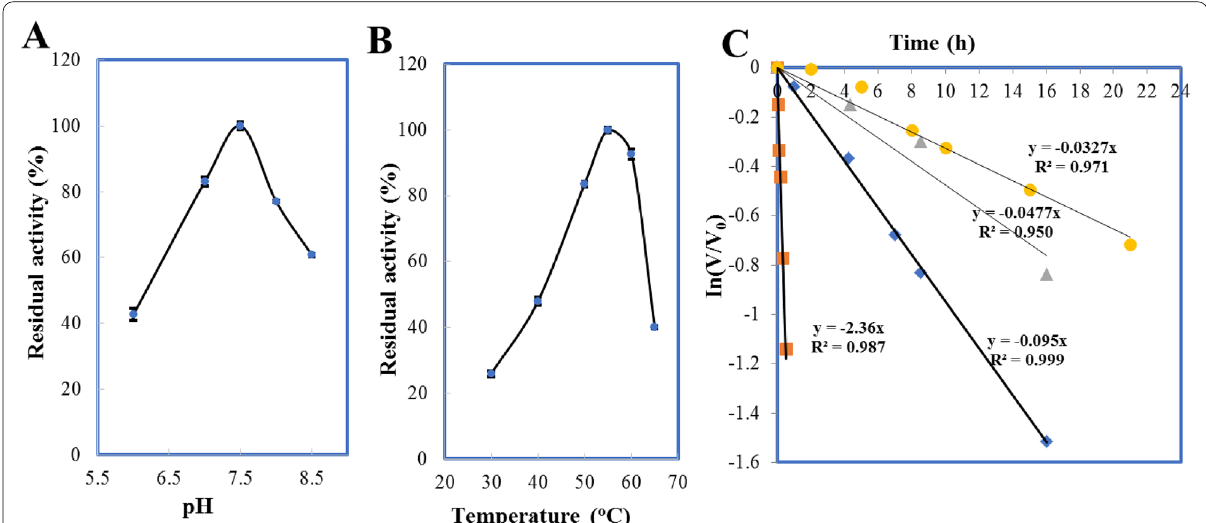
Fig. 1 Characterization of the nicotinamide riboside kinase from Kluyveromyces marxianus . A pH optima of the purified Klm ‑NRK. The activity was measured in the potassium phosphate buffers (pH 6.0–8.5). Relative activity was expressed as a percentage of maximum activity under the experimental conditions. The maximum activity of Klm ‑NRK at pH 7.5 was 8.9 U at various temperatures (30–65 °C) in potassium phosphate buffer (100 mM, pH 7.0). The maximum activity of Klm ‑NRK at 55 °C was 30.3 U (100%). C Thermal inactivation of Klm ‑NRK. Purified Klm ‑NRK (2 mg